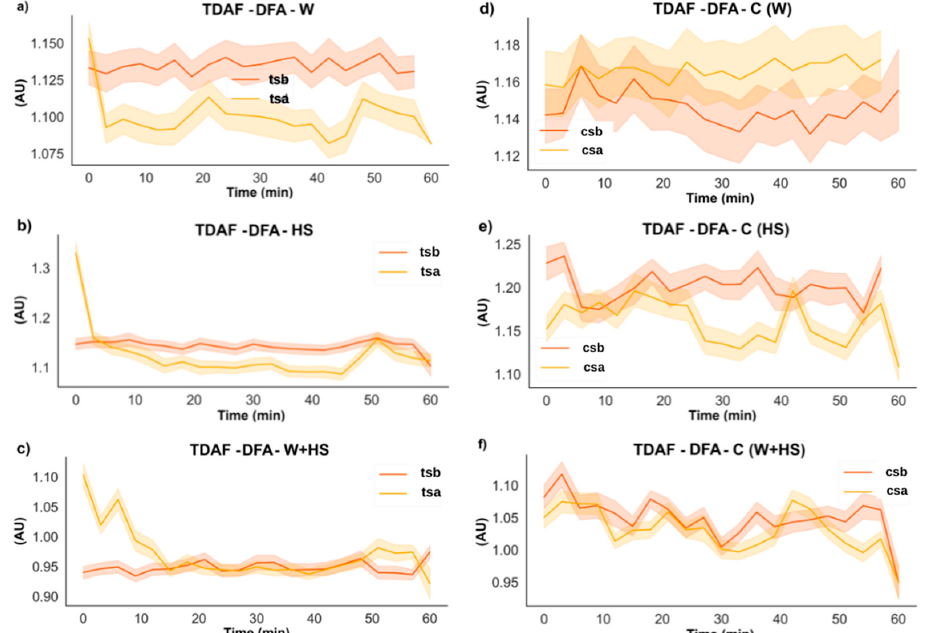
Figure 6. TDAF plots for DFA analysis. Results for ( a ) the systemic wound (W), ( b ) heat shock (HS), and ( c ) wound + heat shock (W+HS). Results of the control plants for ( d – f ) wound C (W), heat shock C (HS), and wound + heat shock C (W+HS), respectively. tsb: treated systemic before stimulus; tsa: treated systemic after stimulus; csb: control systemic before stimulus; csa: control systemic after stimulus. AU: arbitrary unit.